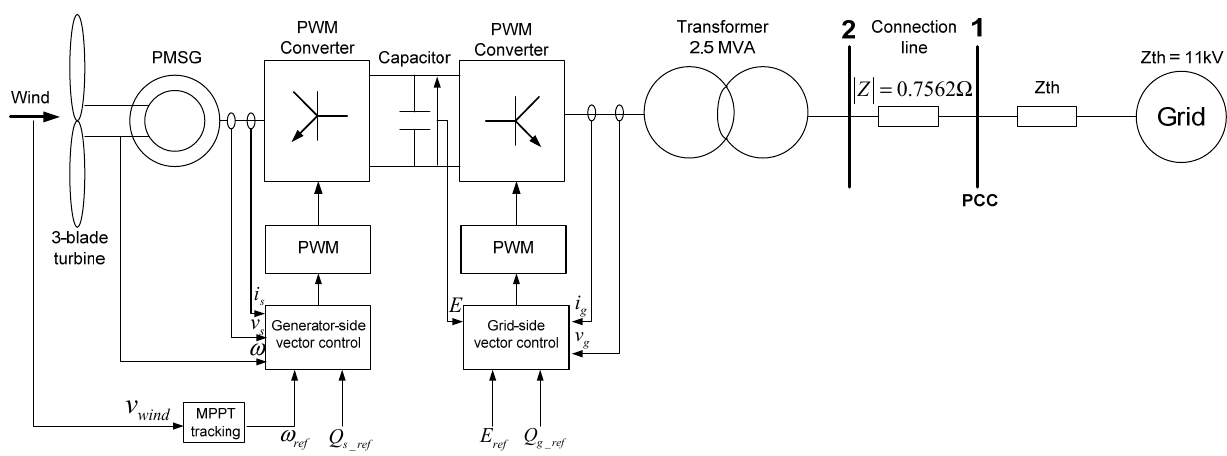
Figure 1. Block diagram of a grid-connected wind turbine with a PMSG and a full-scale